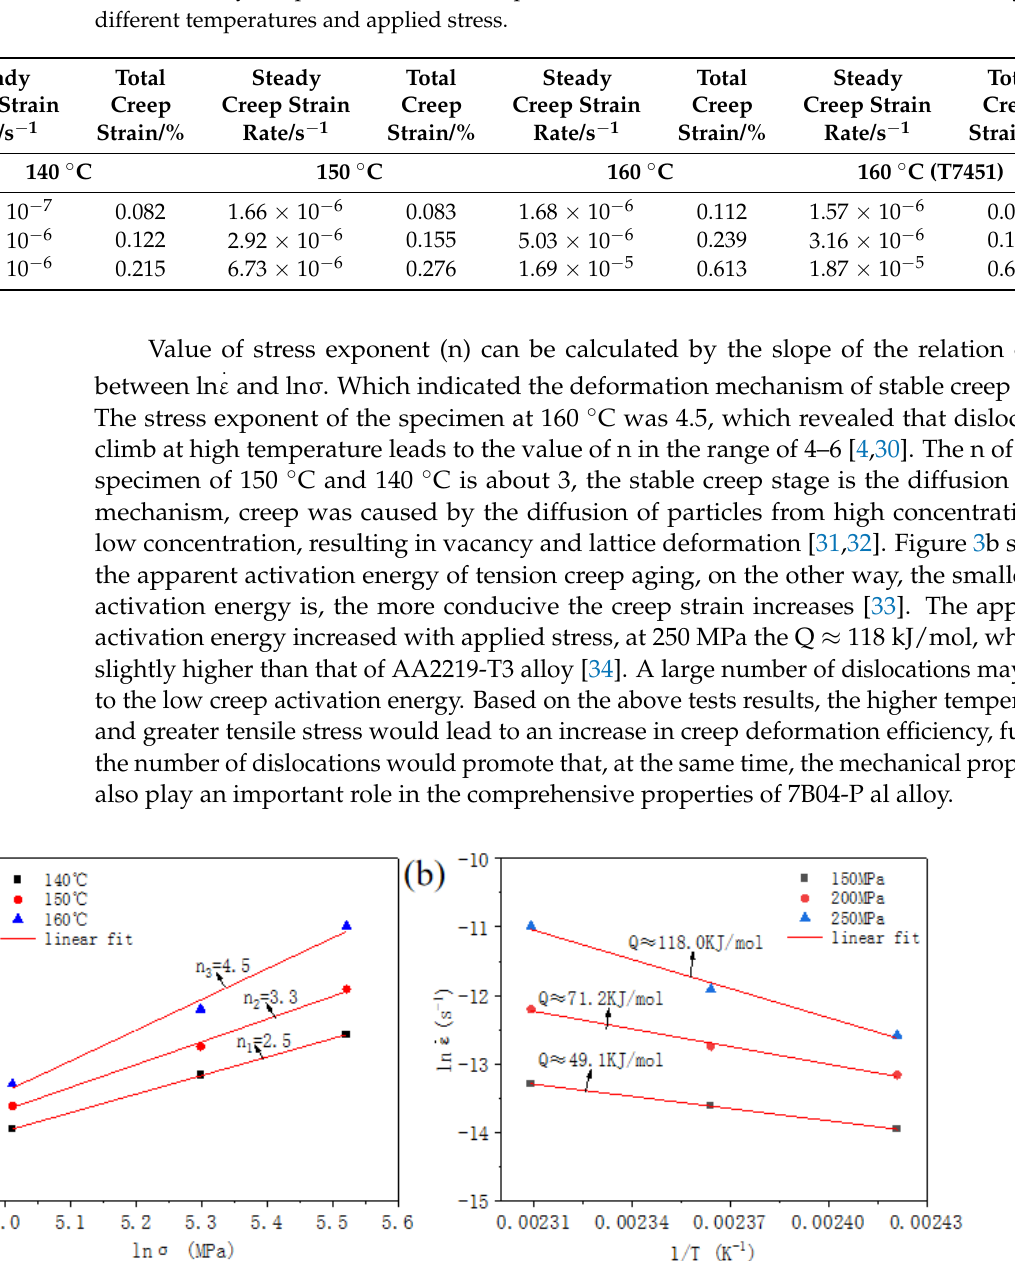
Table 1. Steady creep strain and total creep strain of 7B04-P and 7B04-T7451 aluminum alloy with different temperatures and applied stress.